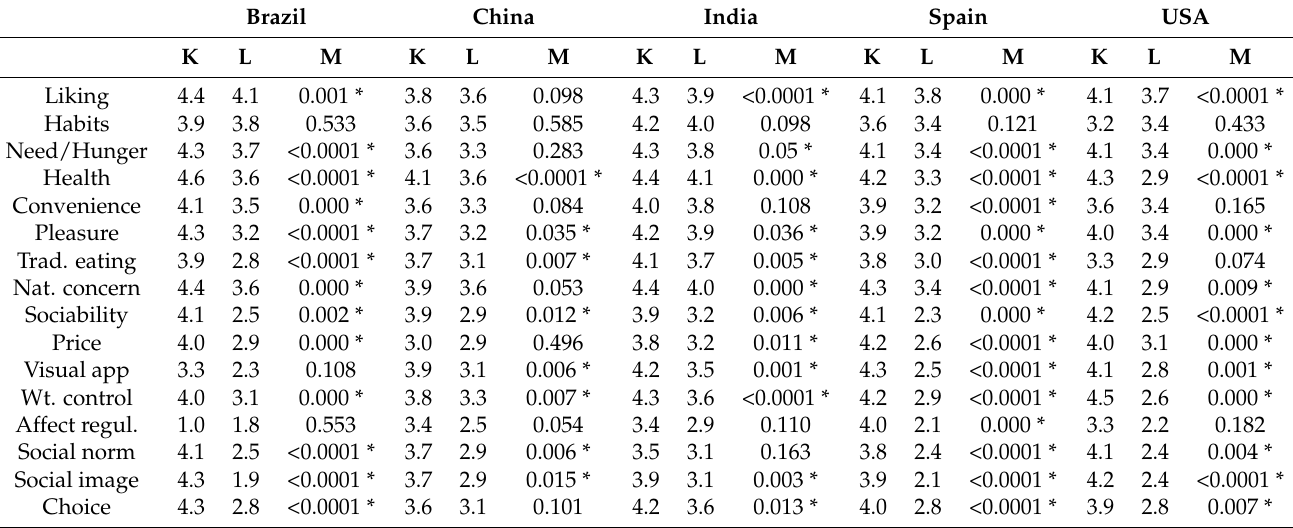
Table A9. Mean scores1 for RATA and RATING survey formats and p -values for the corresponding two-sample t -test for each motivation construct for dairy foods in all five countries.